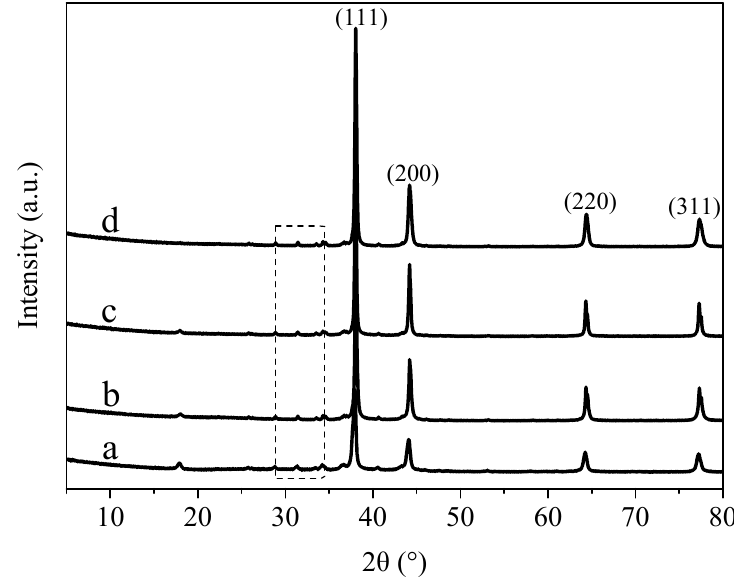
Figure 3. XRD patterns of the samples: ( a ) AgNWs/GNs-1; ( b ) AgNWs/GNs-2; ( c ) AgNWs/GNs-3 and ( d ) AgNWs/GNs-4.